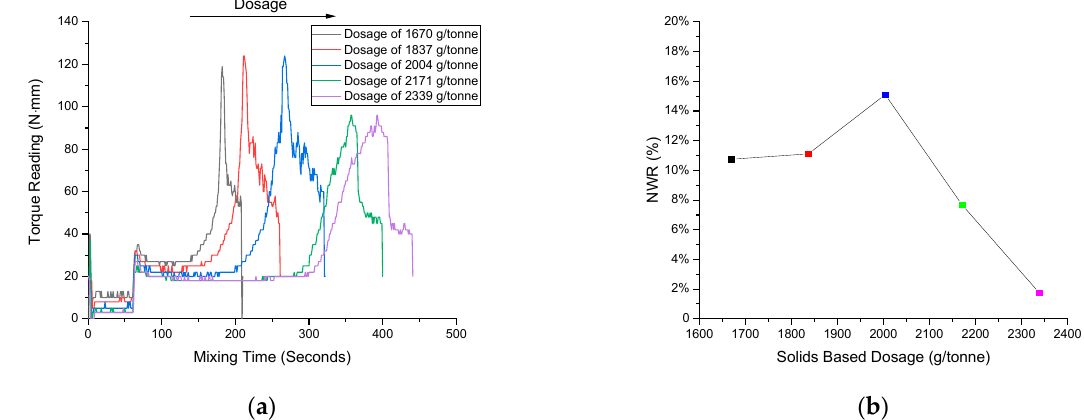
Figure 7. Visual distinction corresponding to the stages of flocculation and torque progress. The red line represents the torque progress during the flocculation.